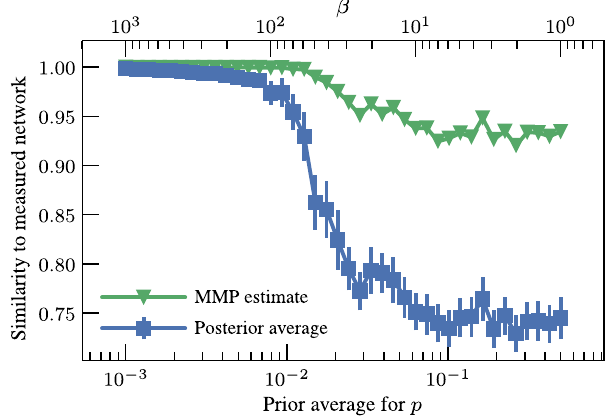
FIG. 11. Average similarity between the posterior samples and the measured C. elegans data as a function of the hyperparameter β (with α ¼ 1 ), which controls the prior belief on the probability p of missing edges (the average of which is shown in the x axis). For reference, the similarity for the MMP estimate is also